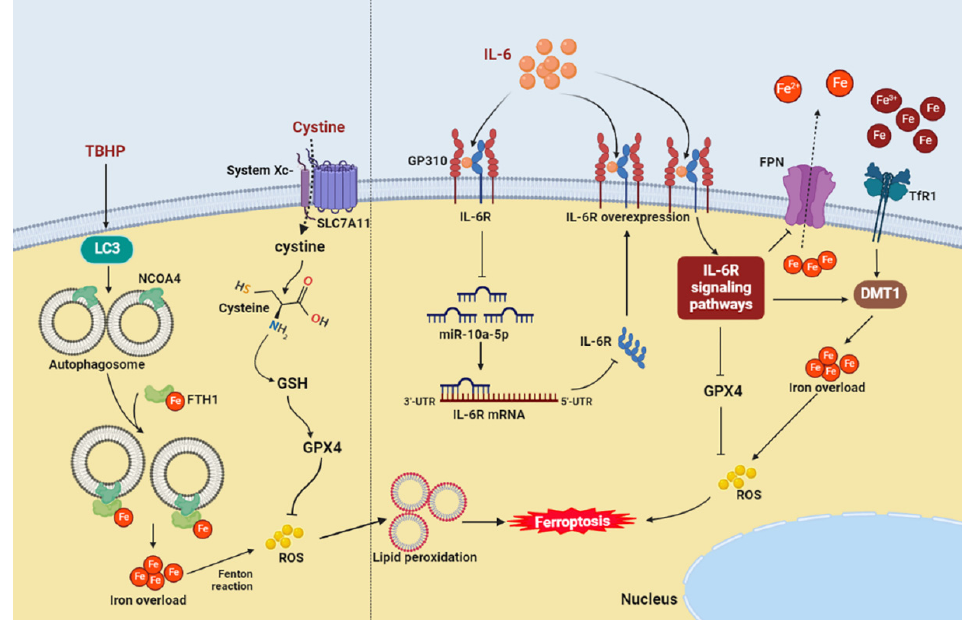
8 of 12 Figure 1. The potential ferroptosis-related pathways in nucleus pulposus cells. AA, arachidonic acid; ATF3, activation transcription factor 3; BMSC, bone marrow mesenchymal stem cell; DMT1,